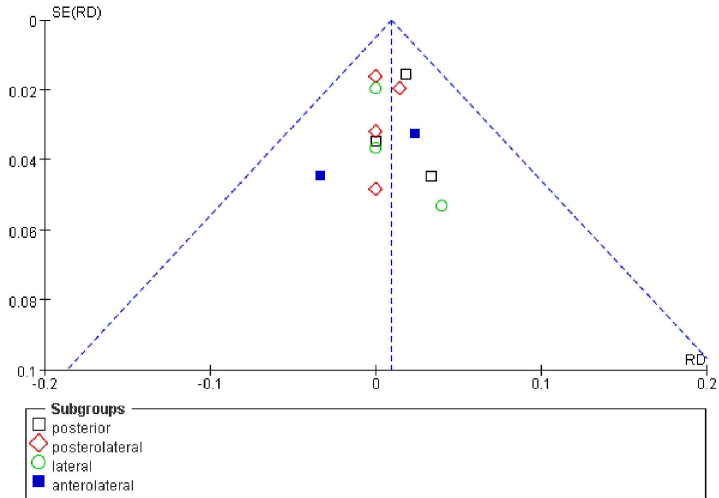
Figure 8. Funnel plot showing minimal publication bias of the complication outcome- infection. SE(RD), standard error (risk differences).